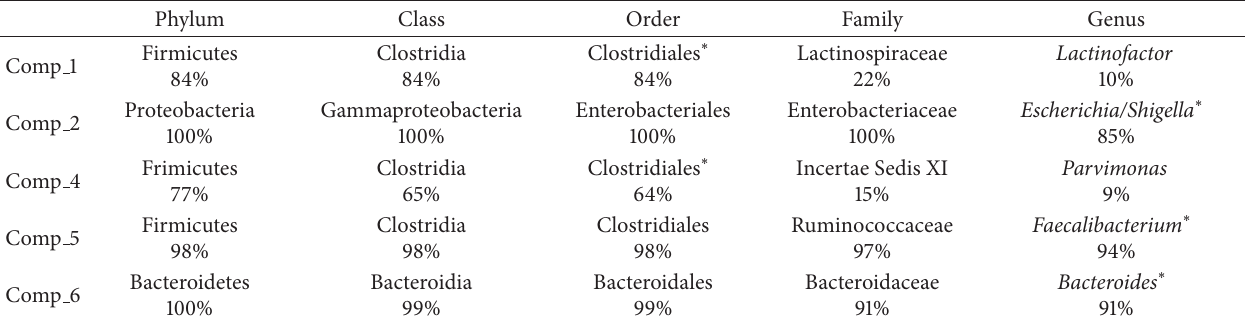
Table 4: The five well-resolved components from the MCR analysis of the results of the direct sequencing classified using the Classifier in Ribosomal Database Project II. Classification at the phylum, class, order, family, and genus levels are shown with the corresponding bootstrap confidence